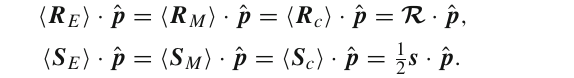
represent the velocity of the partons in the corresponding region of the nucleon. For simplicity, Lorentz contraction effects are not represented. In the rest frame of the nucleon, the three relativistic centers coincide. In a general moving frame they all differ. In the infinite-momentum frame, the relativistic centers of energy and spin merge and are found half a Compton wavelength away from the relativistic center of